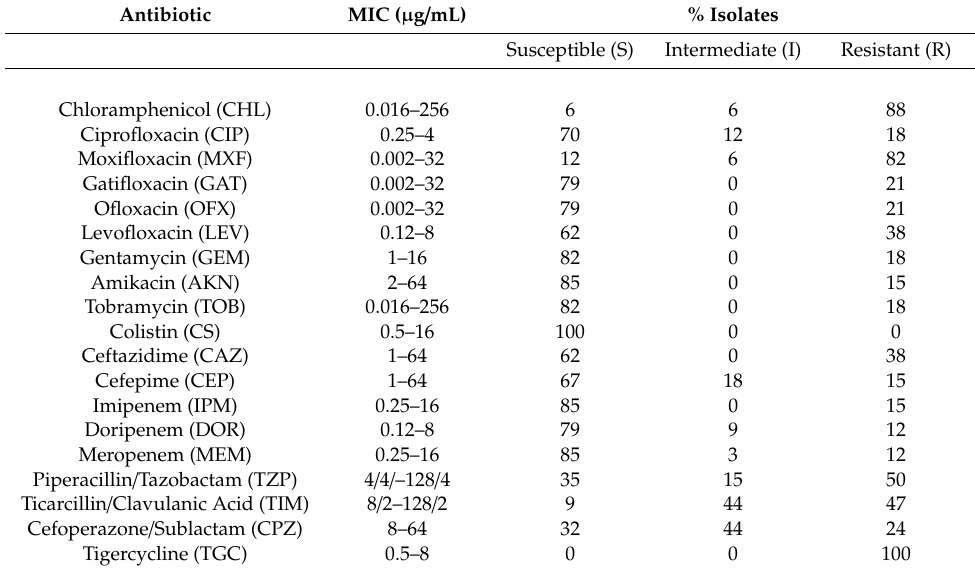
Table 2. Minimum Inhibitory Concentration based Antibiotic Susceptibility Pattern of Ocular Clinical Isolates of P. aeruginosa ( n =